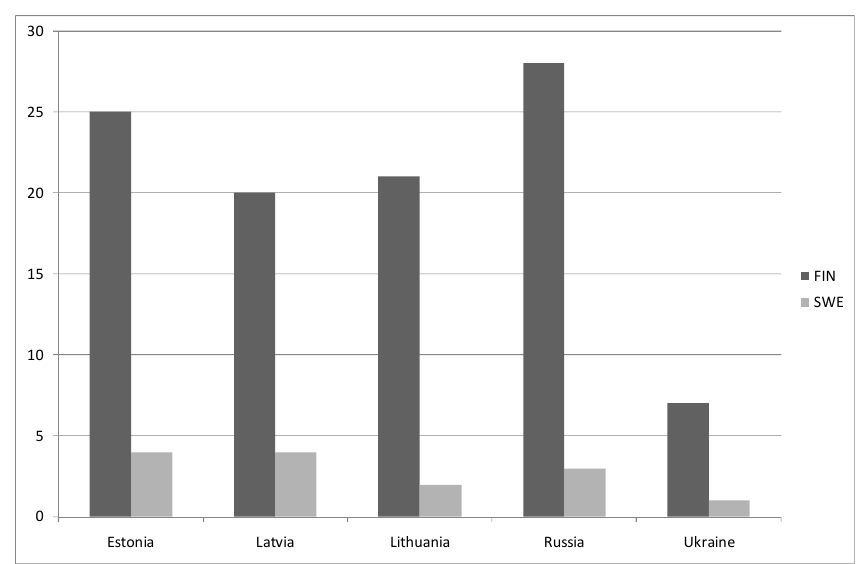
Figure 3 – Share of warehouses (from absolute numbers) in Central and Eastern European Countries (CEEC) during observation period among Finnish and Swedish respondents.